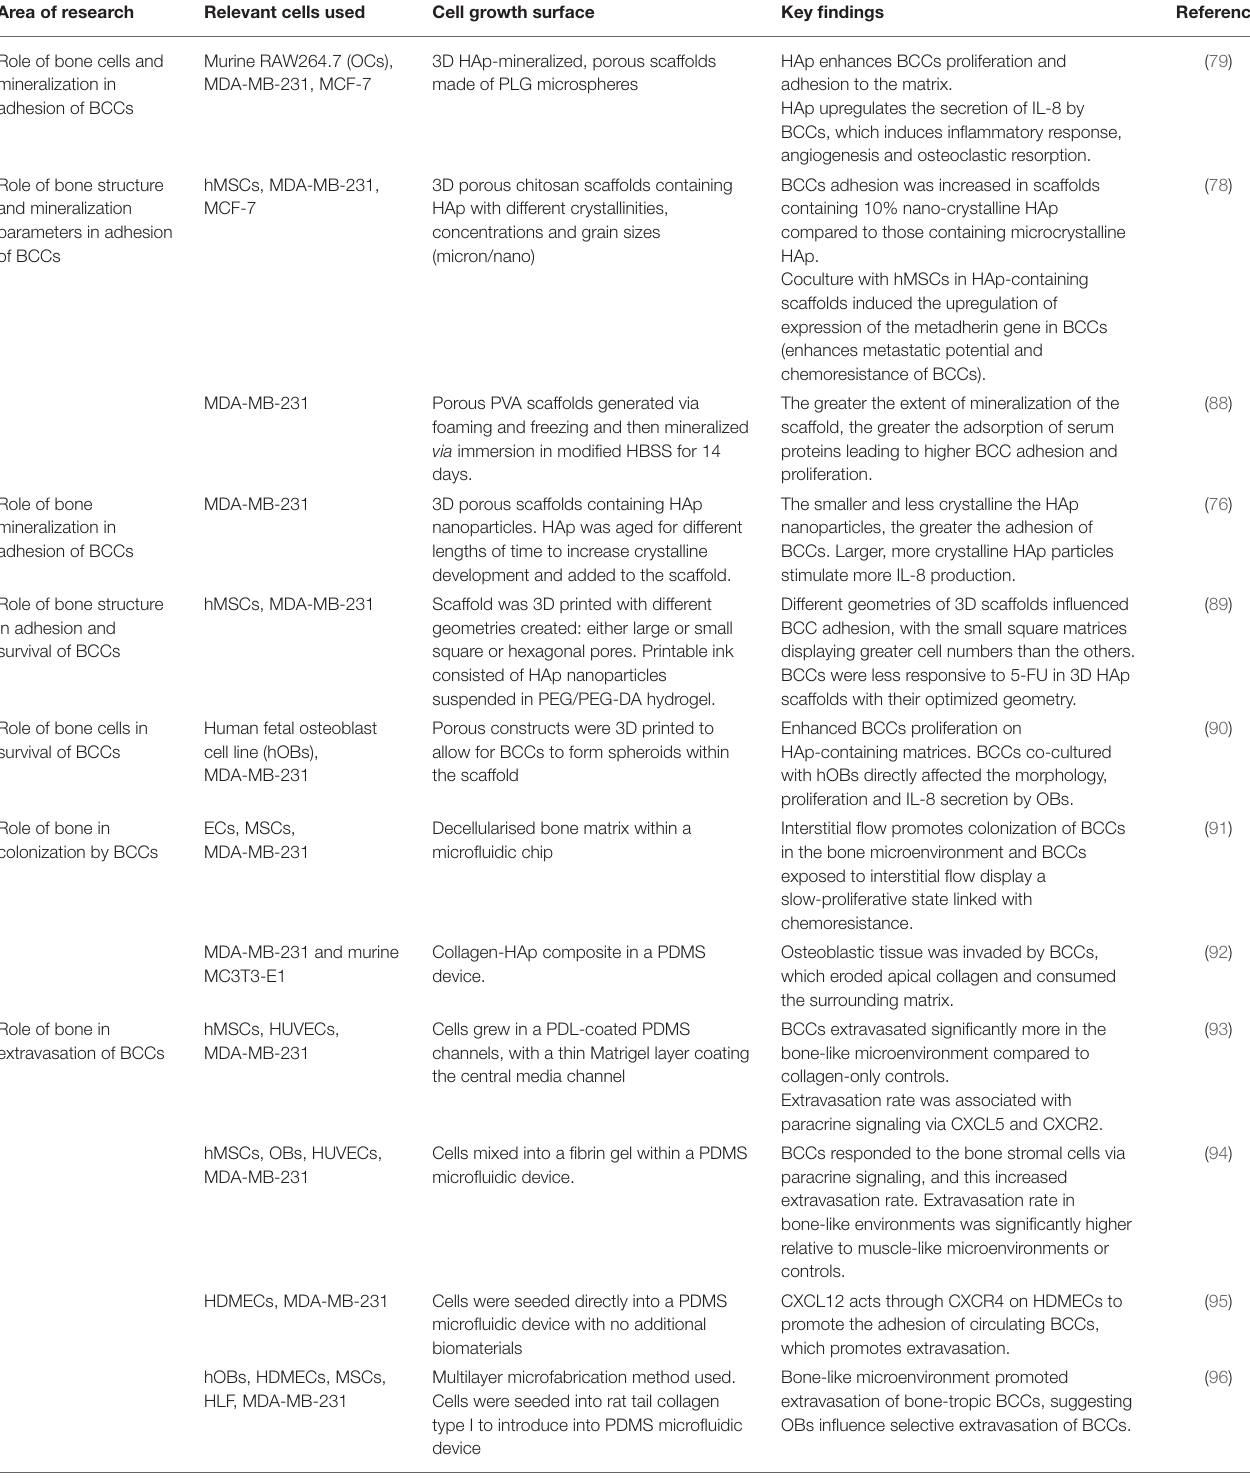
TABLE 1 | Overview of microfluidic systems that study the role of the bone microenvironment in breast cancer metastasis, highlighting biomaterials